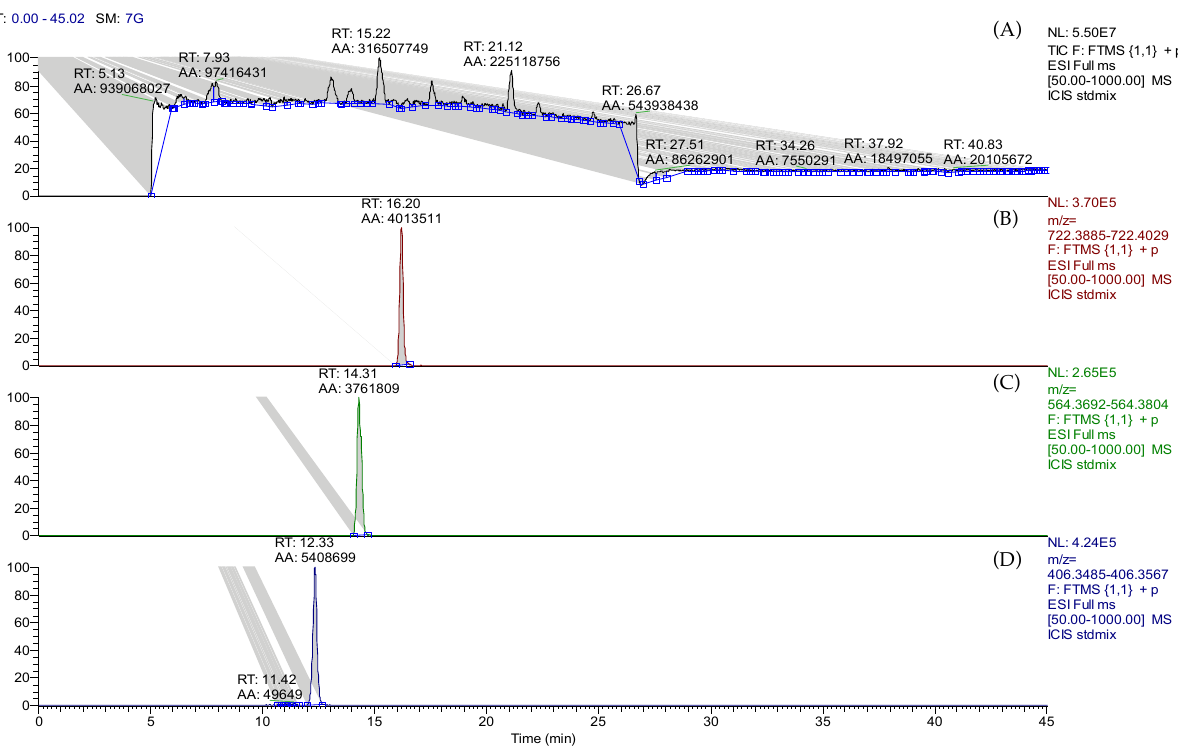
Figure 1. LC-HRMS results. (A) Total Ion Current (TIC) and extracted ion chromatograms (XIC); (B) filtered on the accurate mass of fumonisin B 1 ; (C) partially hydrolyzed form of FB 1 (PHFB 1 ); and (D) hydrolysed fumonisin B 1 (HFB 1 ) in standard